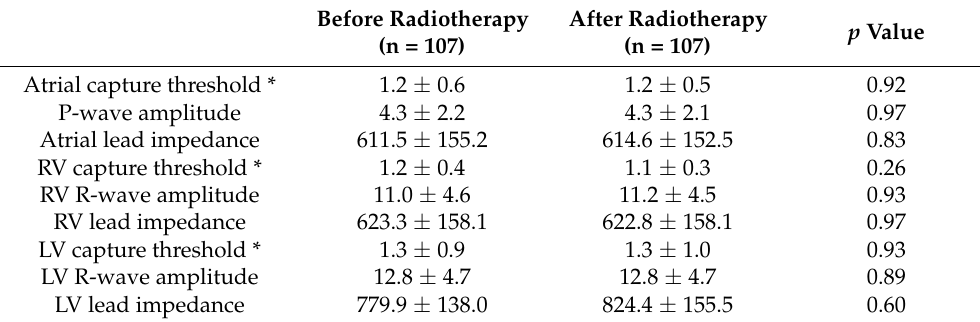
Table 2. Changes in device parameters.